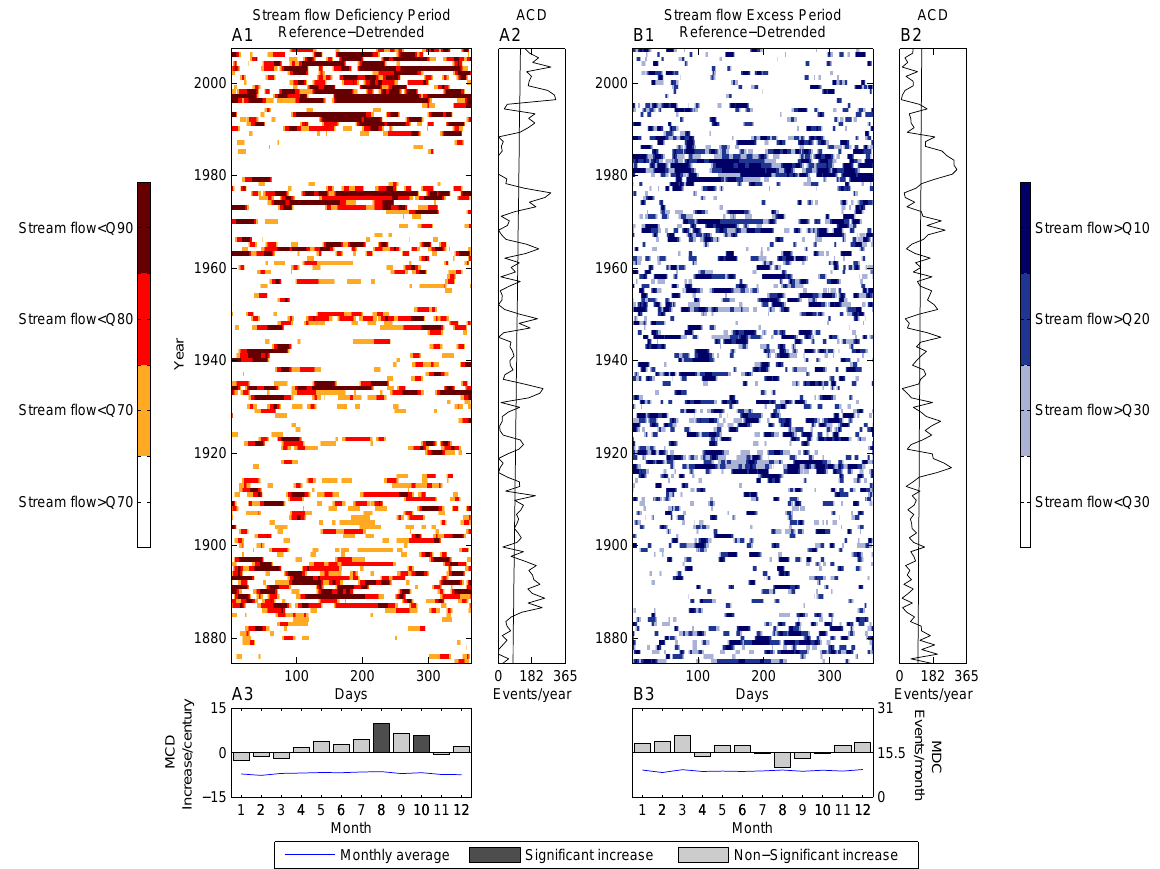
Fig. 7. Two extreme indexes (A – dry & B – wet) with a reference period based on the whole data set after detrending the discharge values. Plot A1/B1 shows the streamflow deficiency/excess period diagrams. Plot A2/B2 shows the ACD, meaning the counts of extreme days (Q30 > Q < Q70) per year. Plot A3/B3 shows the MCD, meaning the monthly average of extreme days (blue line) and the increasing/decrease during 100yr (bars) of extreme days for each